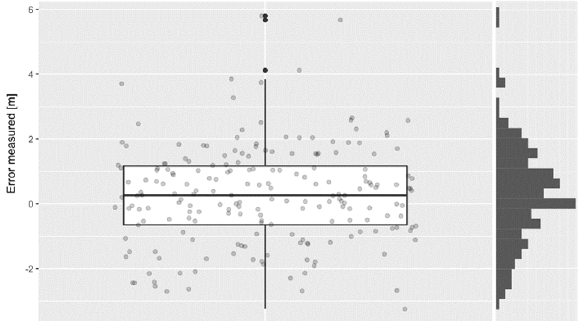
Figure 4. Boxplot (left) and histogram (right) of of error values of DoD obtained by the automatic procedure where the expected value is 0. In the boxplot, grey transparent dots are data points. Black dots are